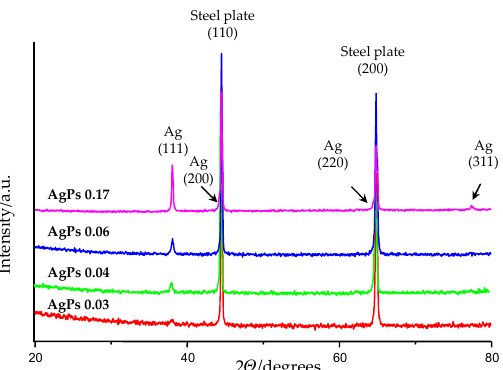
Figure 2. X-ray diffraction patterns of AgPs films deposited using CVD technique. A number of Bragg reflection peaks were observed at 2 θ values of 38.2°, 44.3°, 64.3° and 77.6°, which are indexed to (111), (200), (220) and (311), respectively.